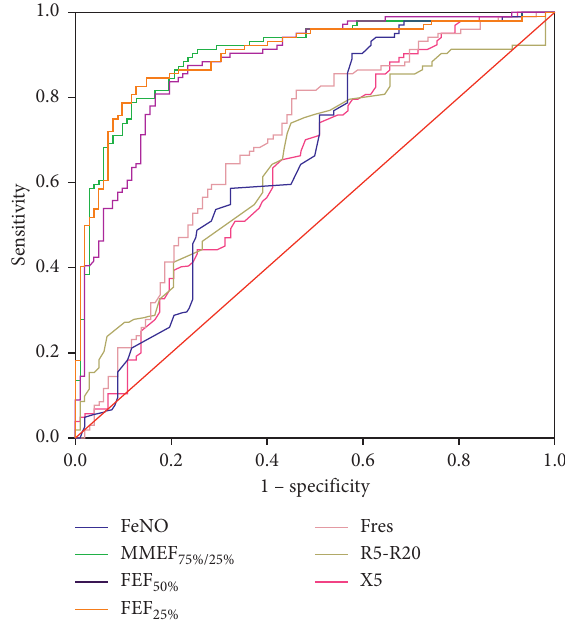
Figure 2: ROC curve of FeNO and small airways function indi- cators for CVA